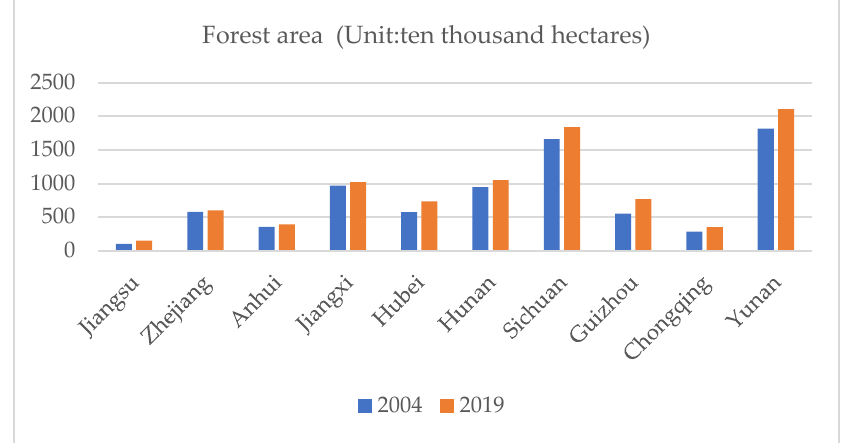
Figure 5. The forest area of YREB. Resources: National Bureau of Statistics of